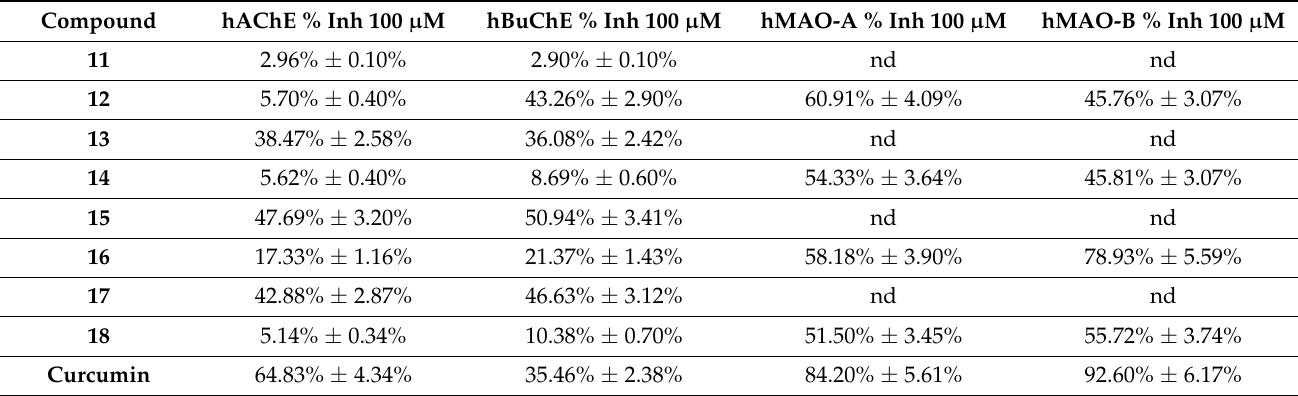
Table 1. Percentage inhibition of human cholinesterases (hAChE and hBuChE) and human monoamine oxidases (hMAO-A and